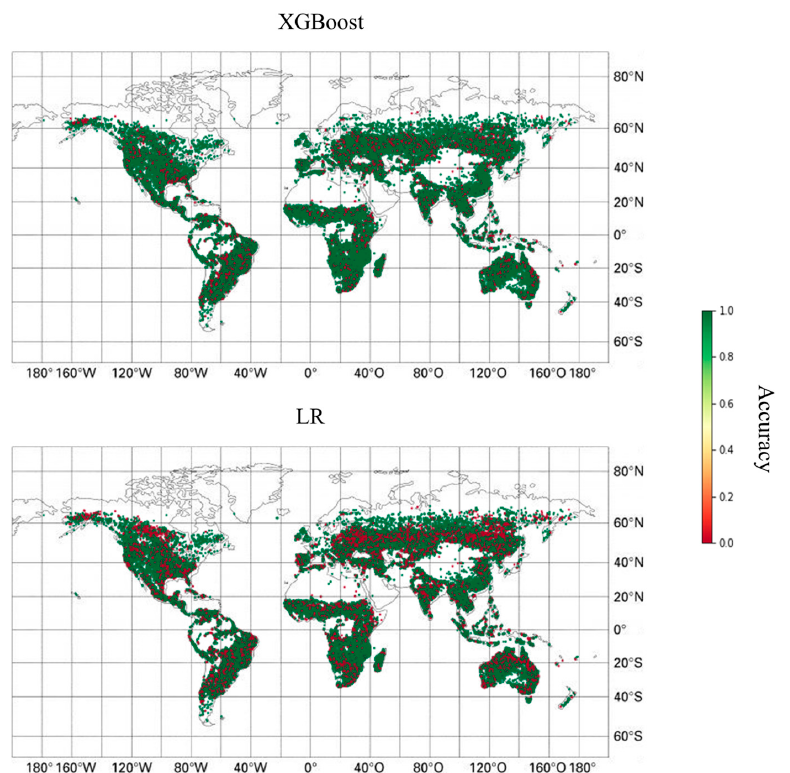
Figure A2. Similar to Figure 4, but for the models which do not include wildfire history variables.